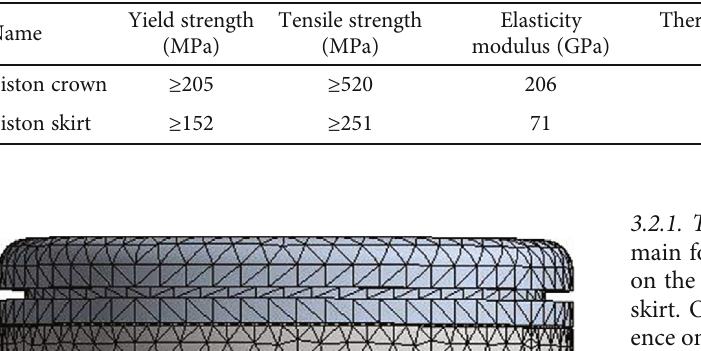
Table 1: Mechanical performance parameters of piston components.